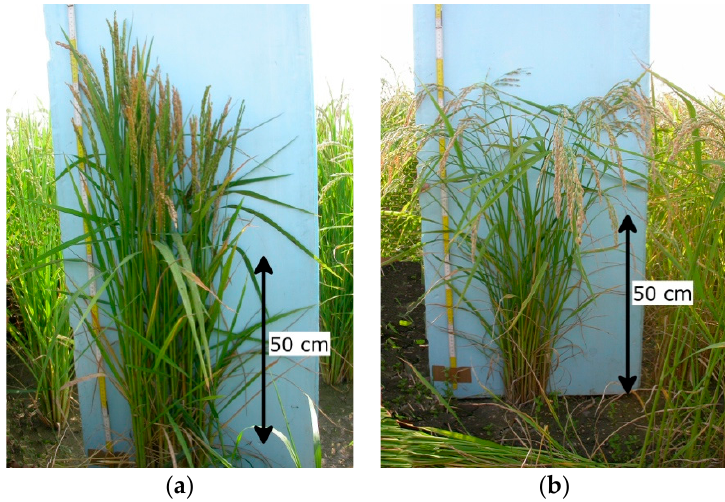
Figure 1. ( a ) A weedy rice population with a compact attitude and upright panicles ( b ) A weedy rice population with an open canopy and a spreading attitude of the branches and droopy panicles.